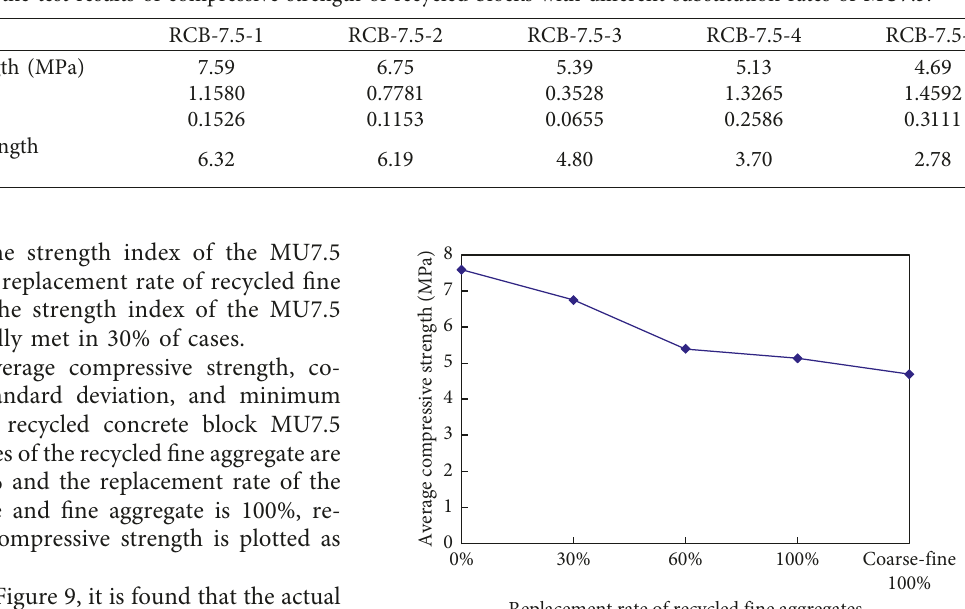
Figure 9: Compressive strength curve of recycled fine aggregates with different replacement